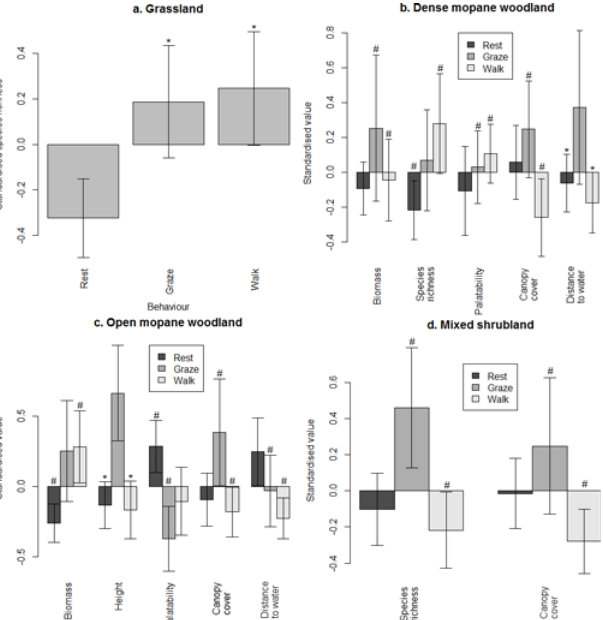
Fig 7. Variables discriminating between microhabitats used for different behaviours during the rainy season. Values marked with (#) and ( * ) were significantly and not significantly different from each other, respectively.